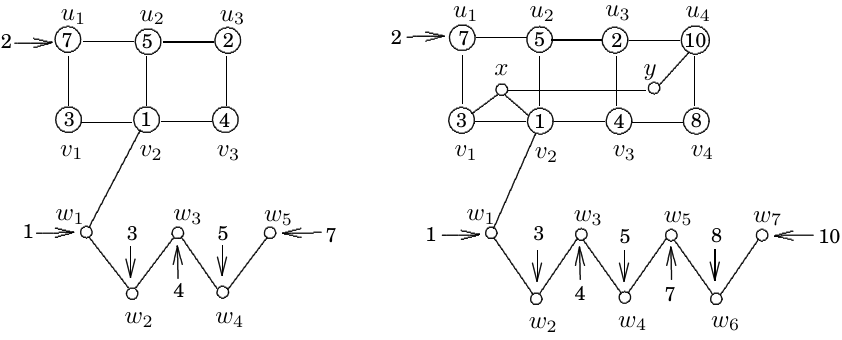
Figure 12: The graphs G